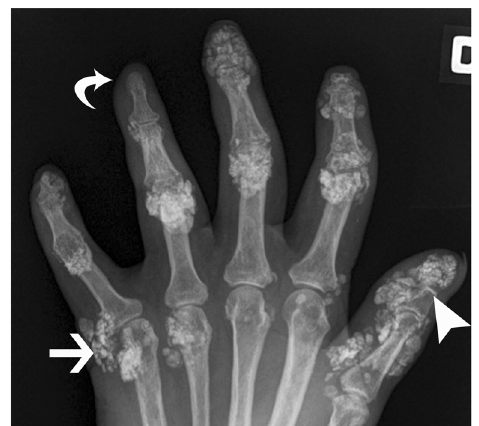
Fig.19 Systemic Sclerosis. Posteroanteriorradiograph ofthe handshows tumoural calcinosis in the soft tissue (arrow). Note acro-osteolysis (arrowhead) and atrophy of soft tissue (curved arrow), characteristic of systemic